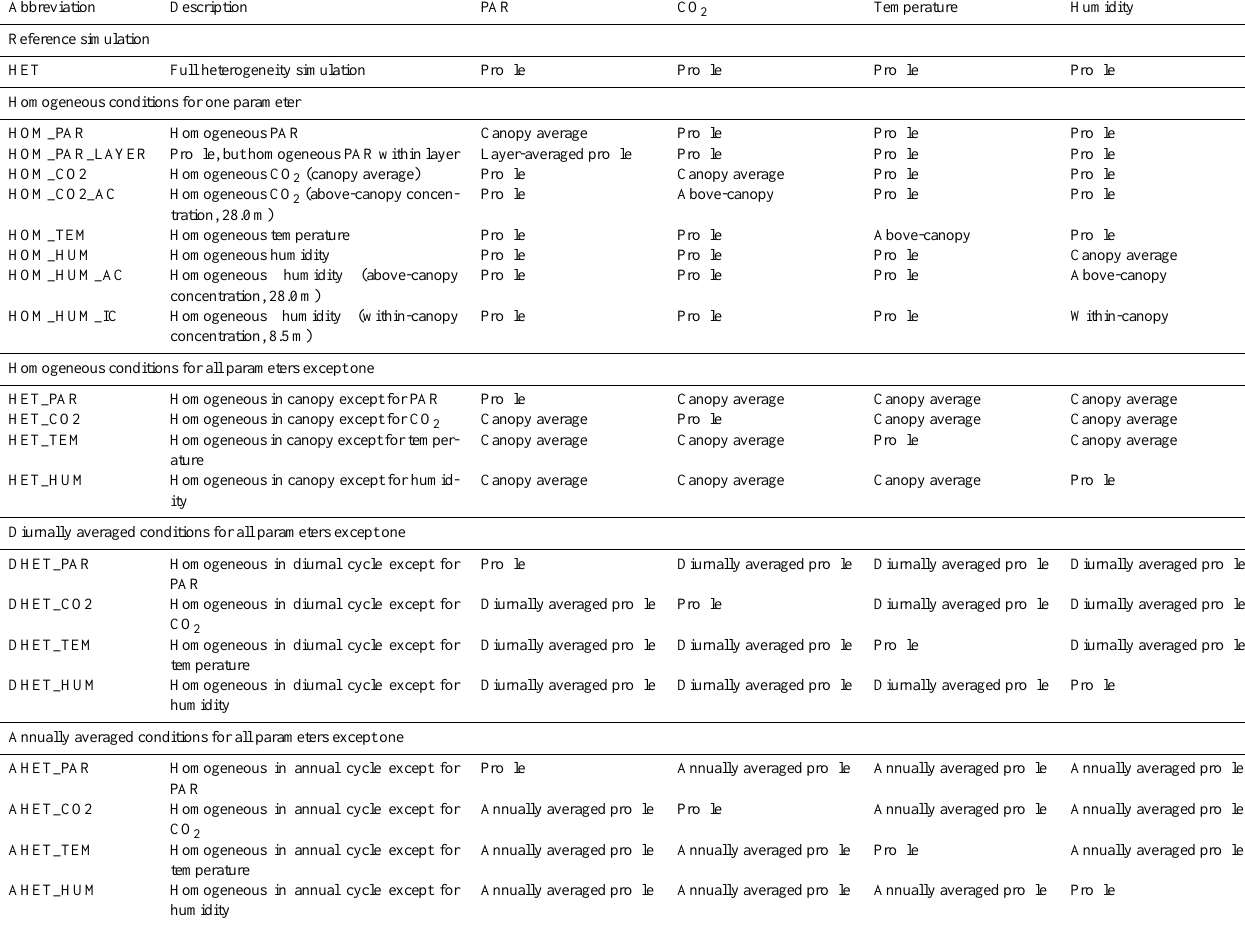
Table 2. Overview of the simulations performed for this